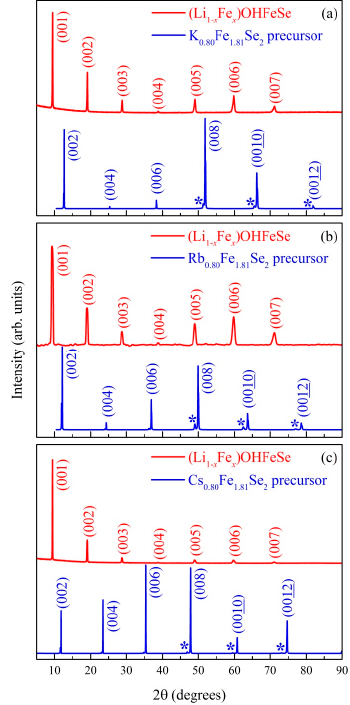
Figure 7. ( a – c ) The X-ray diffraction (XRD) patterns of the cleaved parent A 0.80 Fe 1.81 Se 2 ( A = K, Rb, and Cs) and the ion-exchanged (Li 1 − x Fe x )OHFeSe crystals, respectively [53]. Reprinted with permission from IOP. All rights reserved.